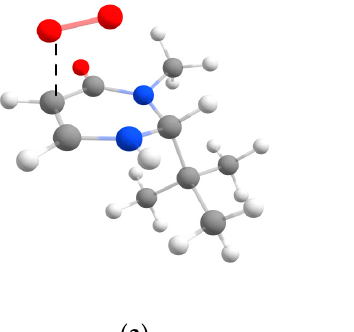
Figure 9 . TS from QST2 calculation starting from the 1 O 2 and 11 ′ as reactants, and: ( a ) the dipolar intermediate, TS1 Z (E = –687.577821 Hartree) or ( b ) the 1,2-dioxetane, TS1 D (E = –687.562242 Hartree) as product.